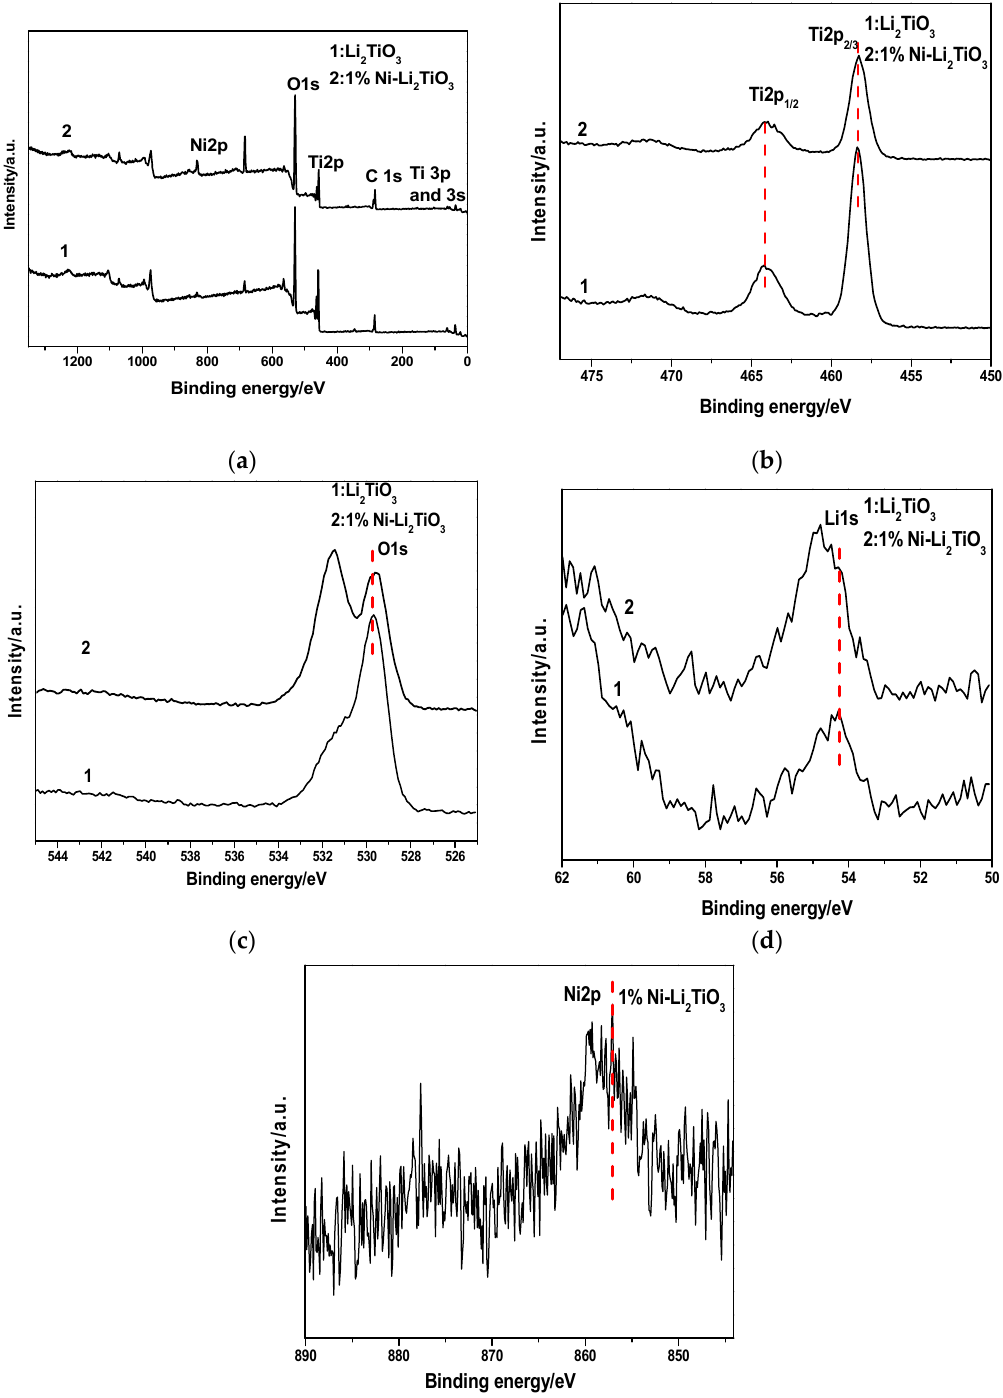
Figure 9. XPS for samples before and after Ni doping. ( a ) Survey; ( b ) Ti 2p peaks; ( c ) O 1s peaks; ( d ) Li 1s peaks; ( e ) Ni 2p peaks. 1s peaks; ( e ) Ni 2p